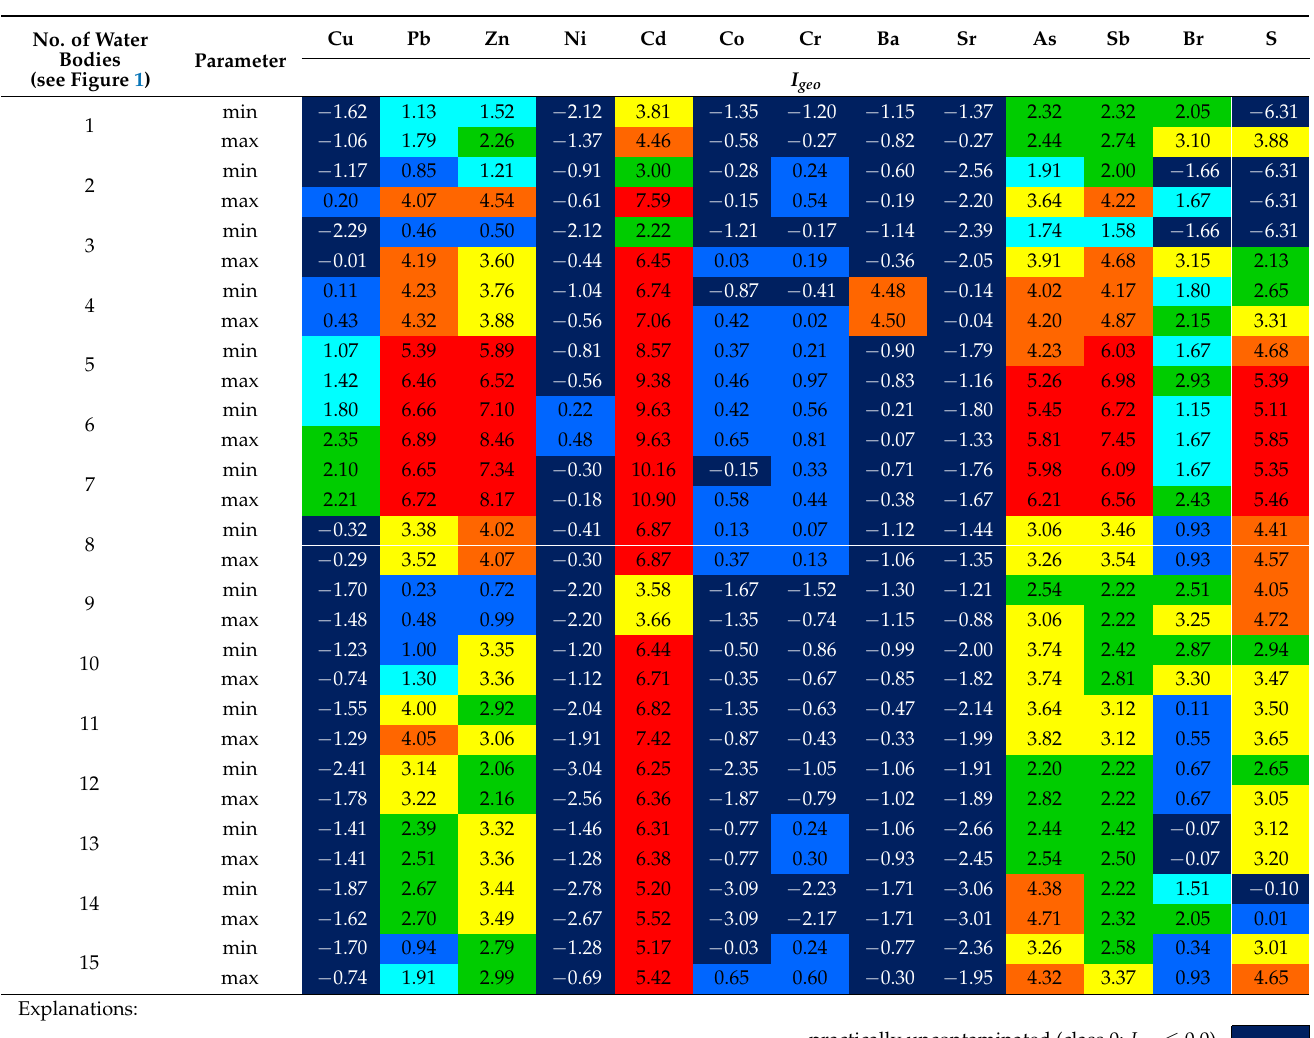
Table 4. Ranges of geoaccumulation index values for metals and non-metals in the bottom sediments of water bodies used for recreational purposes in the Silesian Upland and its